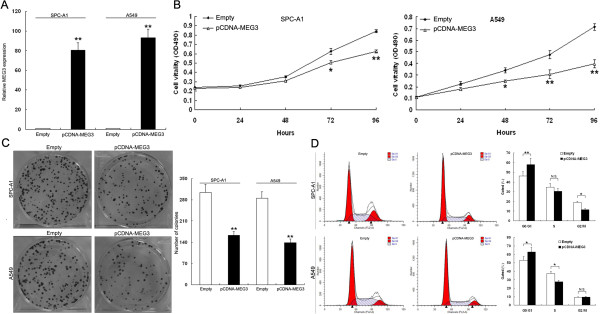
Effects of MEG3 on cell proliferation in vitro. (A) Analysis of MEG3 expression levels in SPC-A1 and A549 cells transfected with PCDNA-MEG3 or empty vector by qRT-PCR. (B) MTT assay was performed to determine the proliferation of SPC-A1 and A549 cells. Data represent the mean ± S.D. from three independent experiments. (C) Colony-forming growth assays were performed to determine the proliferation of SPC-A1 and A549 cells. The colonies were counted and captured. (D) The bar chart represented the percentage of cells in G0/G1, S, or G2/M phase, as indicated. All experiments were performed in biological triplicates with three technical replicates.*P < 0.05, **P < 0.01.